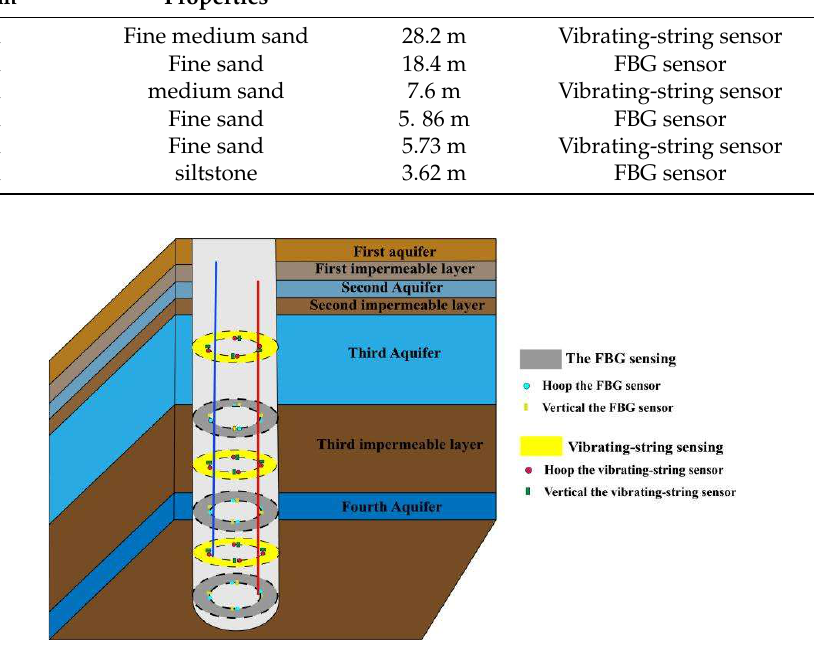
Figure 8. Arrangement of shaft wall monitoring